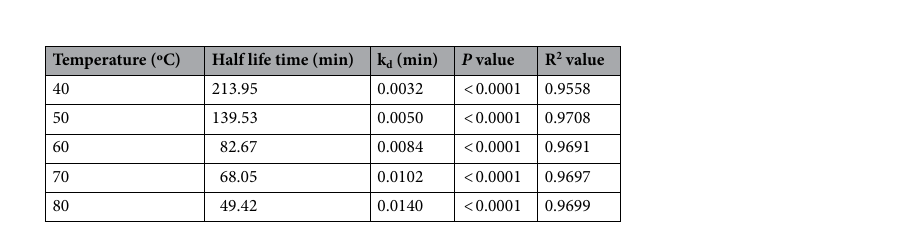
Table 9. Half-life time (T 1/2 ) and heat deactivation constant (k d ) of endoglucanase produced by Bacillus subtilis strain